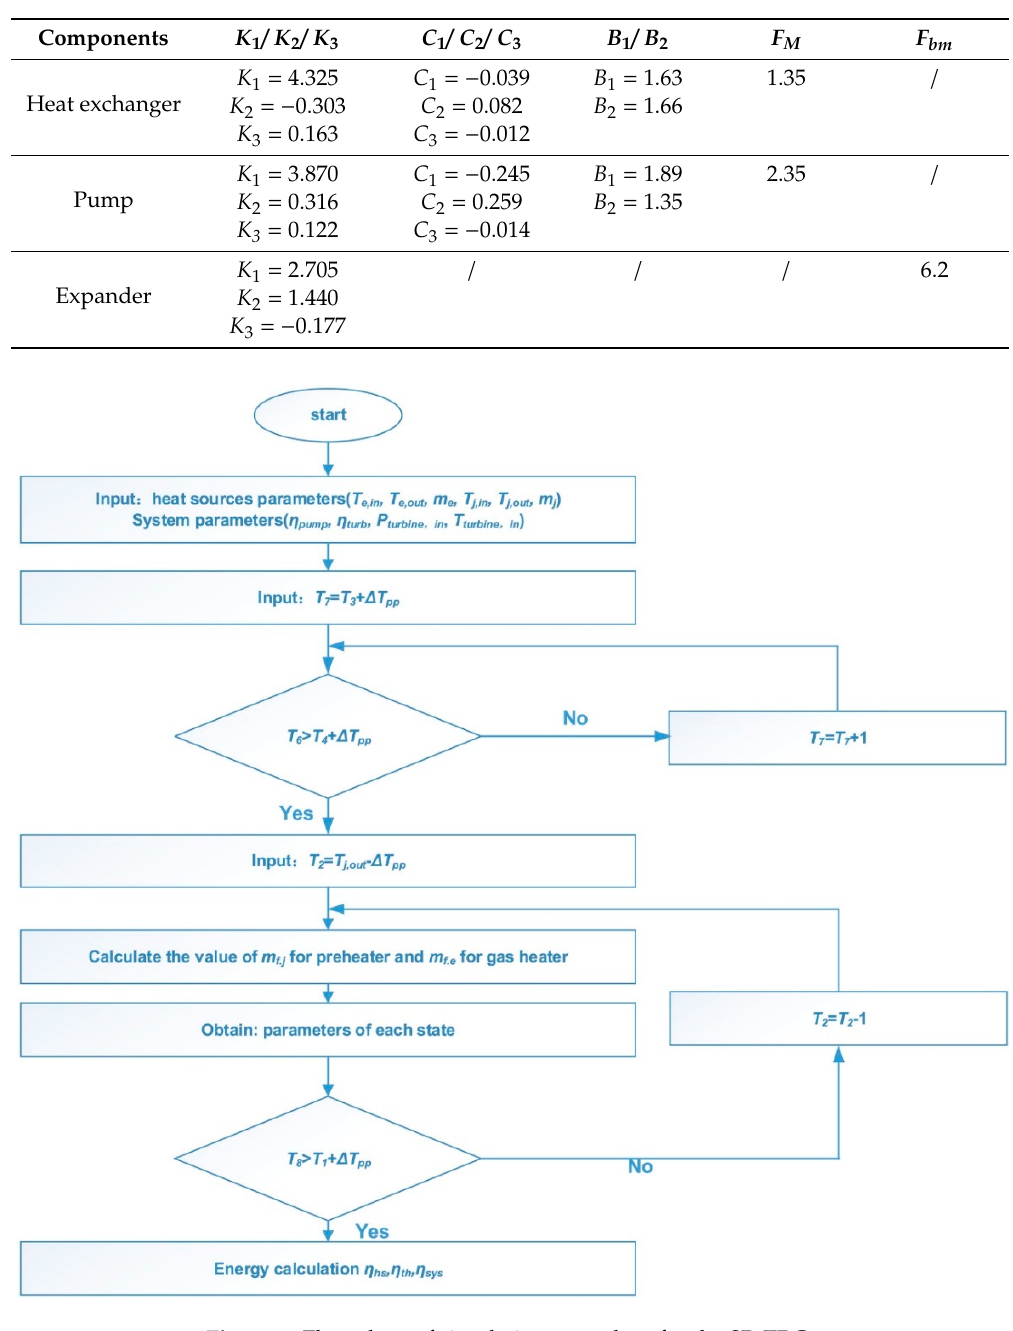
Figure 2. Flow chart of simulation procedure for the SR-TRC .